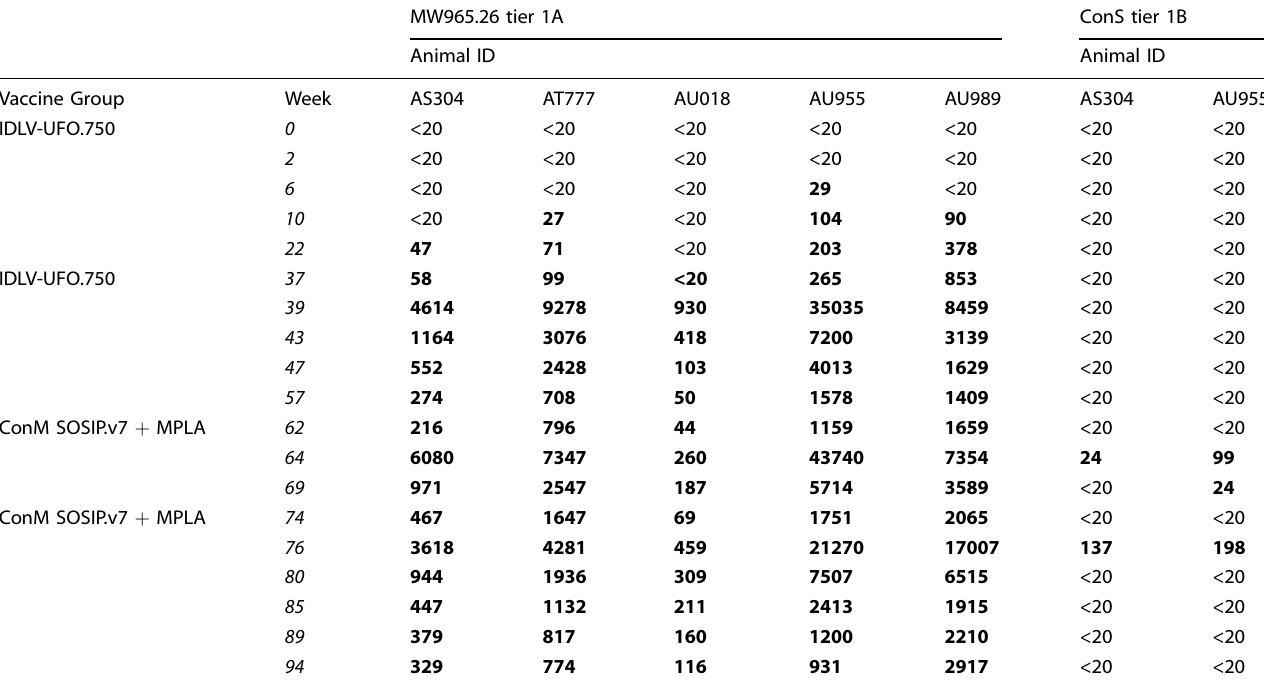
Table 2. Serum neutralization activity against the clade C tier 1A MW965.26 and the Consensus tier 1B ConS viruses.